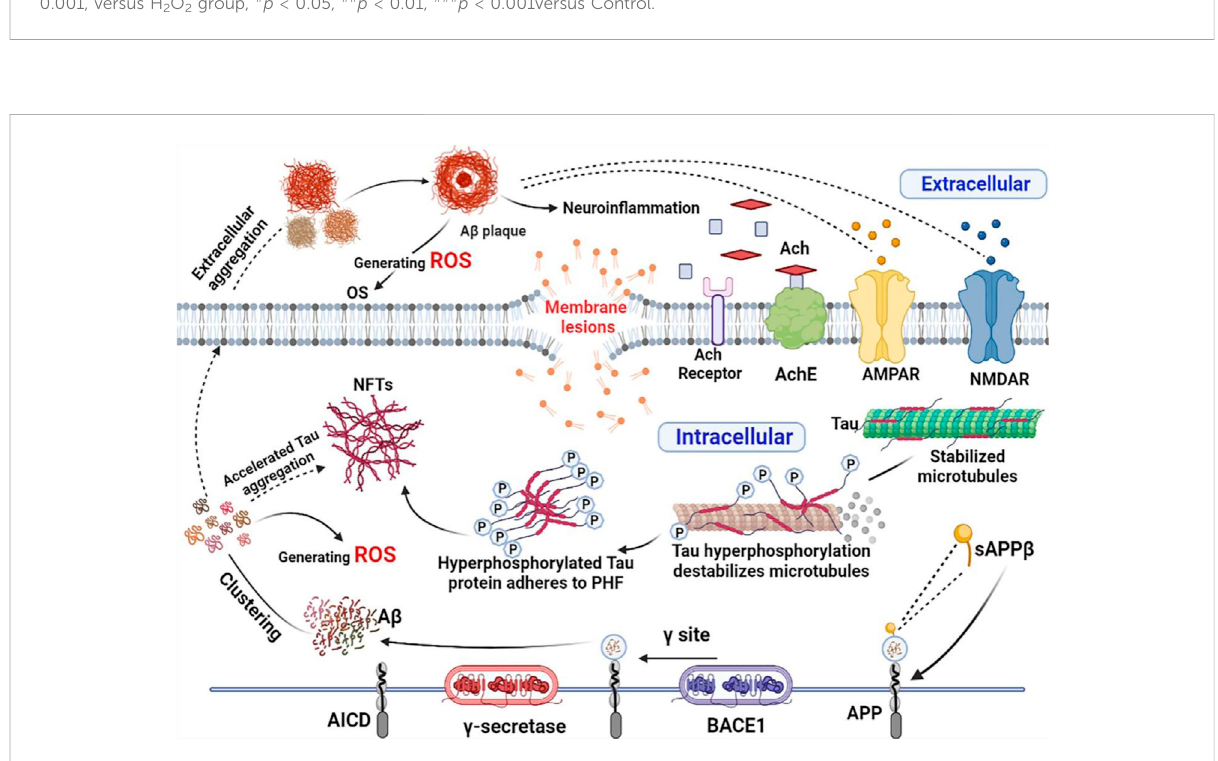
Oxidative stress combined with A β , abnormal Tau and neuroin fl ammation contribute to the development of AD. The fi gure was created employing online software named